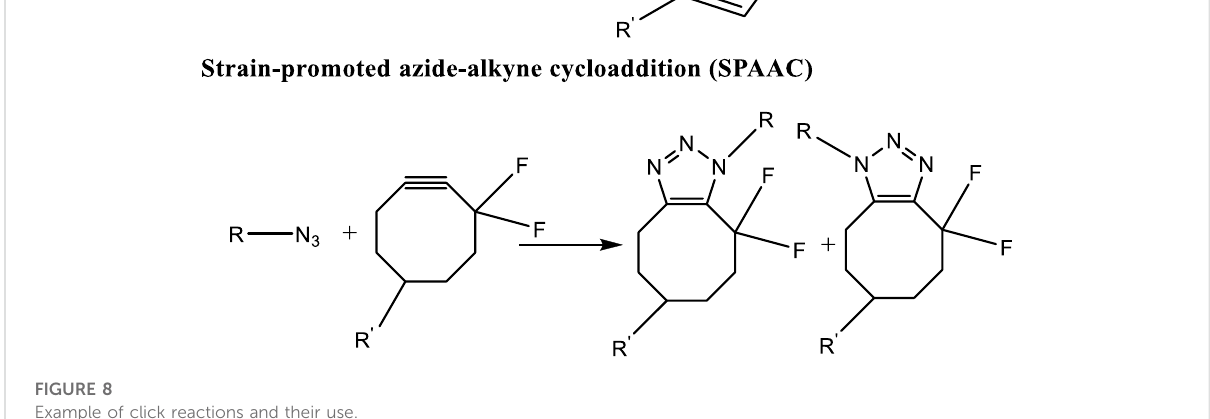
FIGURE 8 Example of click reactions and their